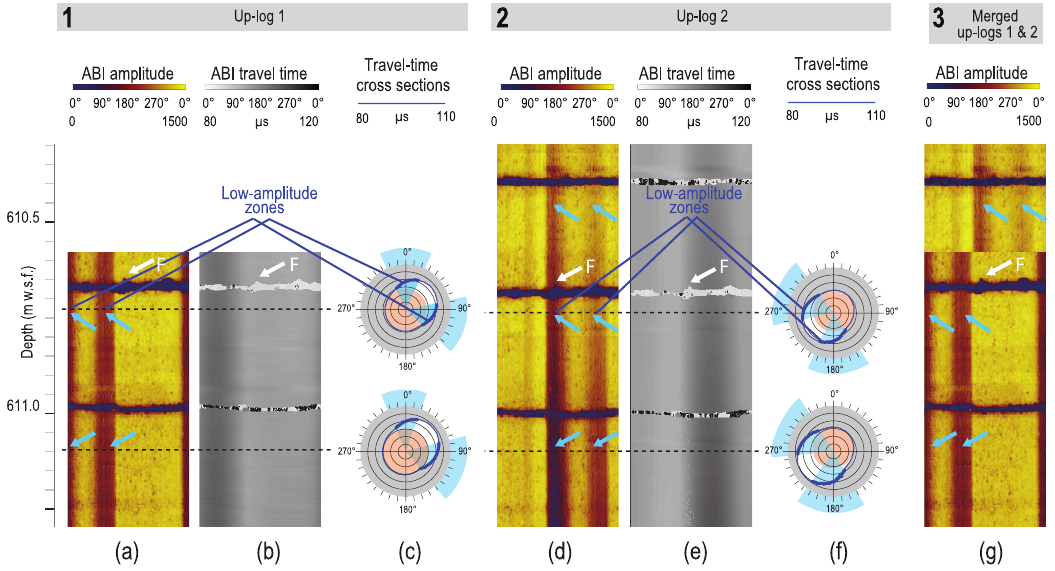
Figure 5. Example of tool eccentering effect in a non-circular borehole. (1) Up-log 1; (2) Up-log 2; (3) merged Up 1 and Up 2 logs. Two dark low-amplitude stripes (blue arrows) are observed on the ABI amplitude images (a, d) . Their location is highlighted with the bold blue lines on the travel-time cross sections (c, f) . Over the same interval, the azimuth of these stripes varies depending on the up-log (1 or 2), resulting in a stepped change in stripe orientation on the merged image (g) . This is interpreted as a change in tool eccentering between the two successive acquisition passes. The sedimentary feature “F” (white arrows), which shows the same azimuth on both up-logs (a, d, g) , attests to the correct orientation of both sets of images. Note that travel-time cross sections’ lower limits have been set to 80µs (c, f) . mw.s.f. is meter wireline depth below